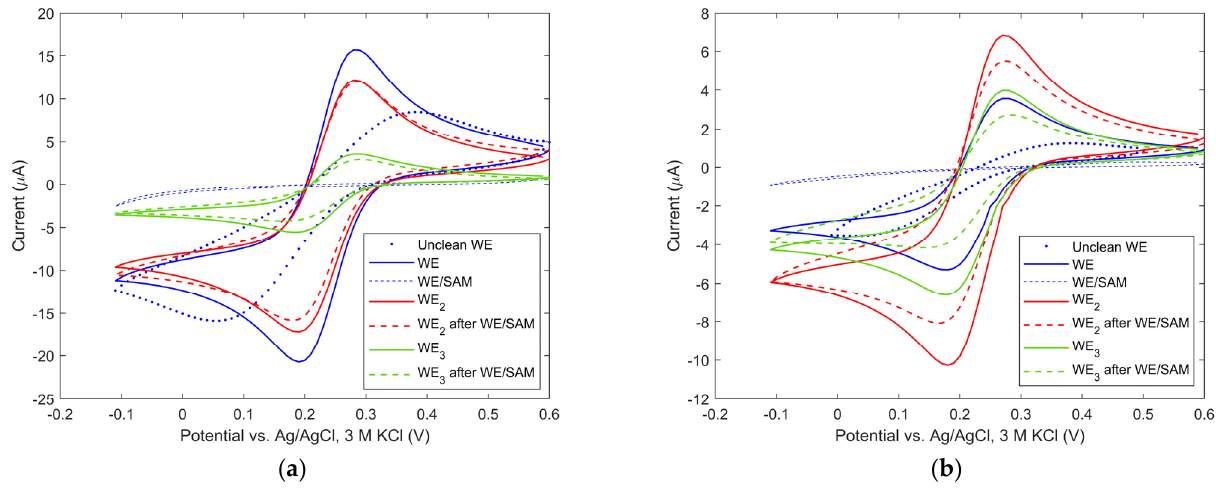
Figure 4. Cyclic voltammograms of 2 mM [Fe(CN) 6 ] 3 − /4 − in an uncleaned, a cleaned and a WE/SAM- modified electrode chip with ( a ) large and ( b ) small electrode design in 0.1 M KCl supporting elec- trolyte.